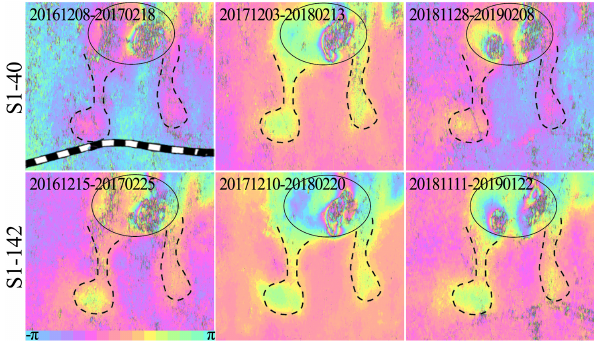
Figure 9. Example of interferograms produced from S1-40 and S1- 142 of box (a) in Fig. 3. The ellipses show the primary subsidence area induced by underground mining. One color fringe stands for approximately 2.8cm displacement in the LOS. The dashed lines show the secondary subsidence area caused by complicated factors, e.g., groundwater drain out and/or fault activation due to under- ground